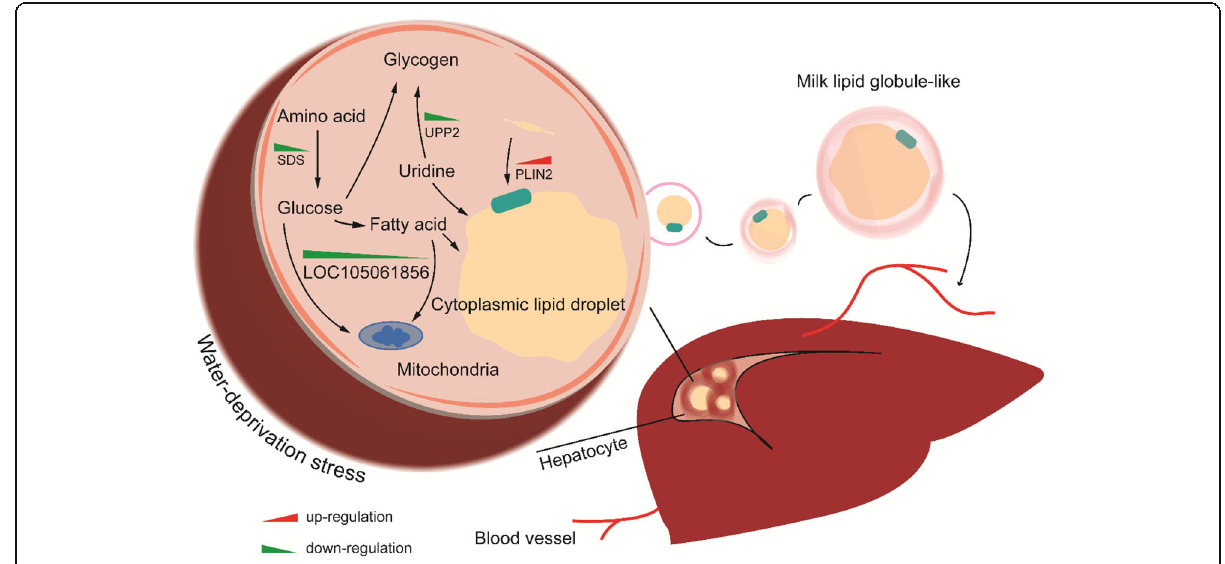
Fig. 7 Improved uridine, glucose and lipid metabolism under water-deprivation stress in camel